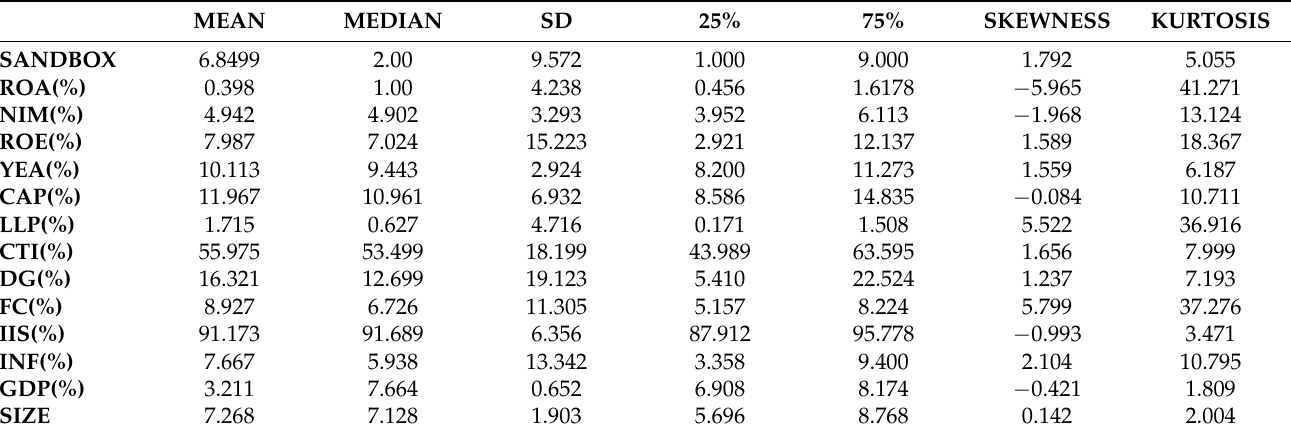
Table 2. Descriptive